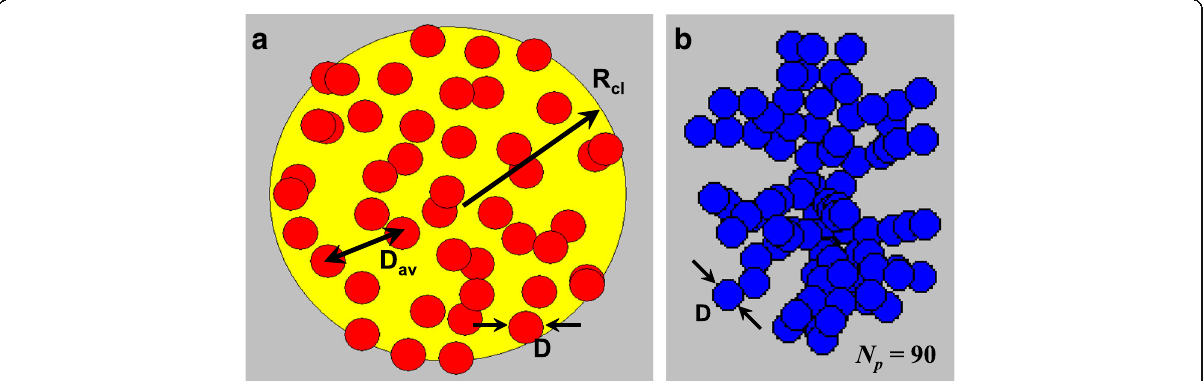
Fig. 1 Geometry of quasi-spherical random 3D cluster of single-domain nanoparticles ( a ) and fractal cluster ( b ) with fractal descriptors D f = 2.1 and k f =